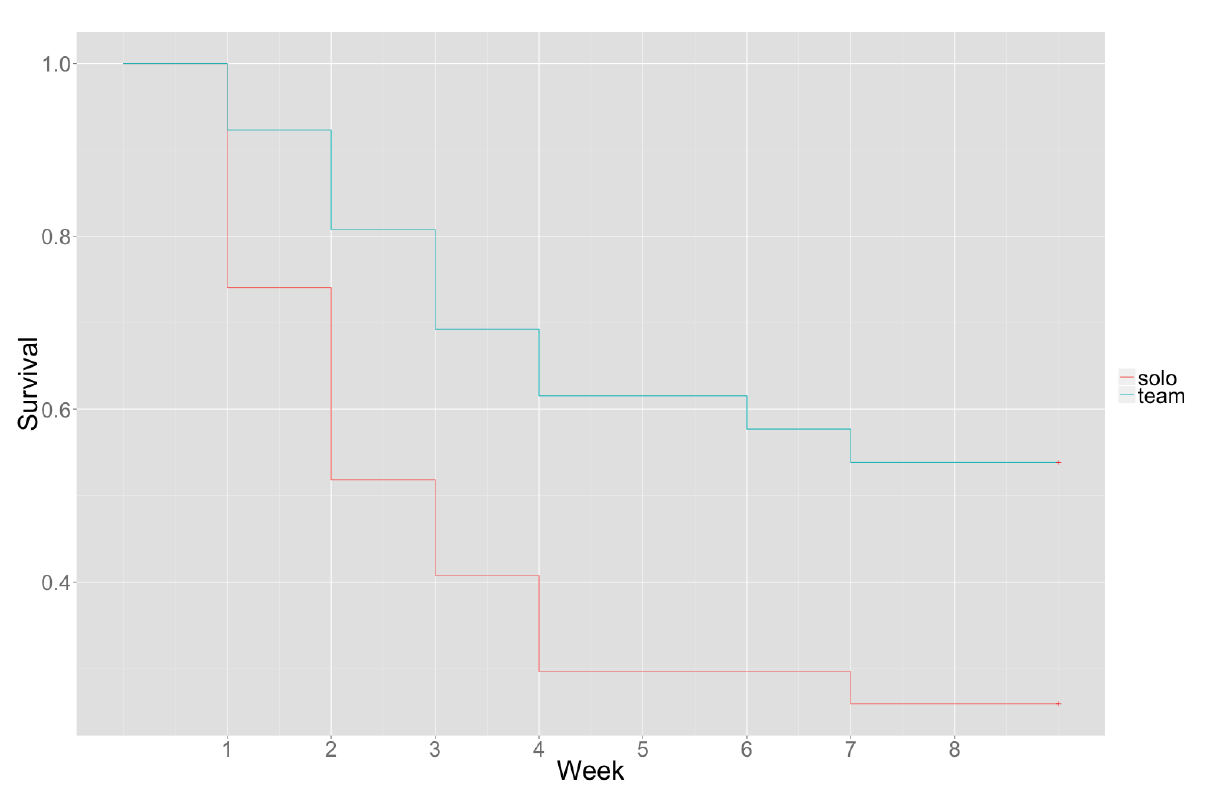
Figure 8. Survival curves for participants in Mobile-Team (Green) and Mobile-Solo (Red) conditions showing a significantly higher survival rate (ie, “adherence” in the Mobile-Team condition; P =.02).